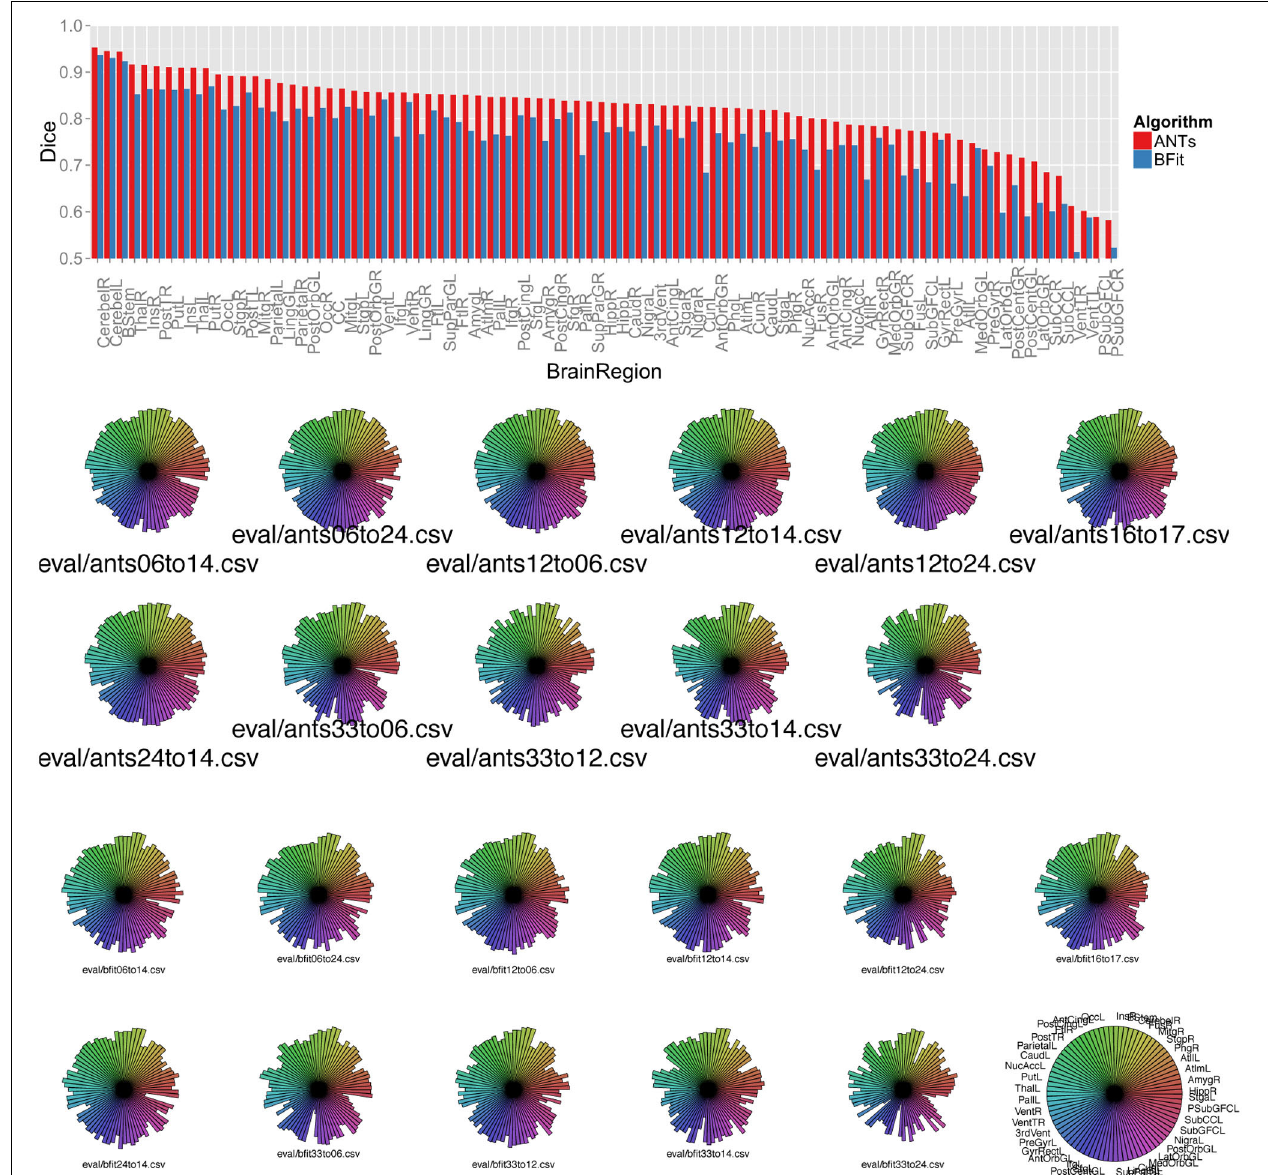
FIGURE 7 | Above, a barplot shows the mean Dice score for each region and each algorithm, sorted by ANTs performance. Below, we use star plots of per-brain-region Dice overlap to compare, for each subject, the ITK 4 implementation of SyN with the ITK 3 -based BRAINSFit algorithm. The